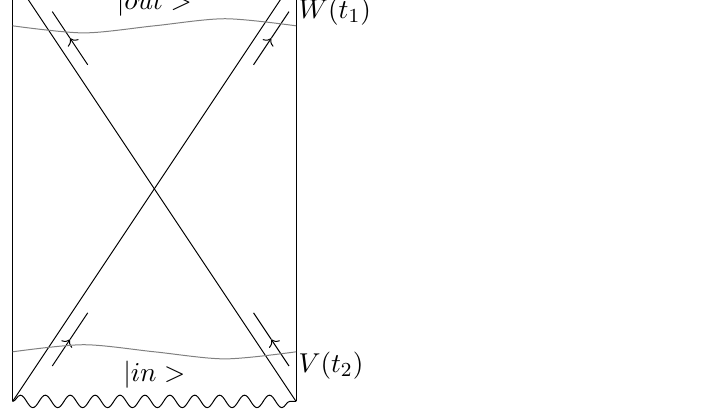
Figure 1 . in and out sates in the Penrose diagram. The data on the in and out slices are given by eq.